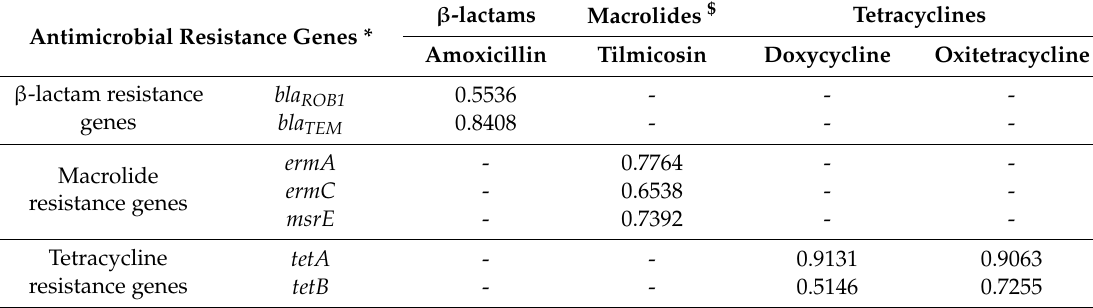
Table 4. p -values obtained after studying the association between resistance genes and a phenotype resistant for β -lactams, macrolides and tetracyclines in the 48 Pasteurella multocida isolates. β Antimicrobial Resistance Genes *